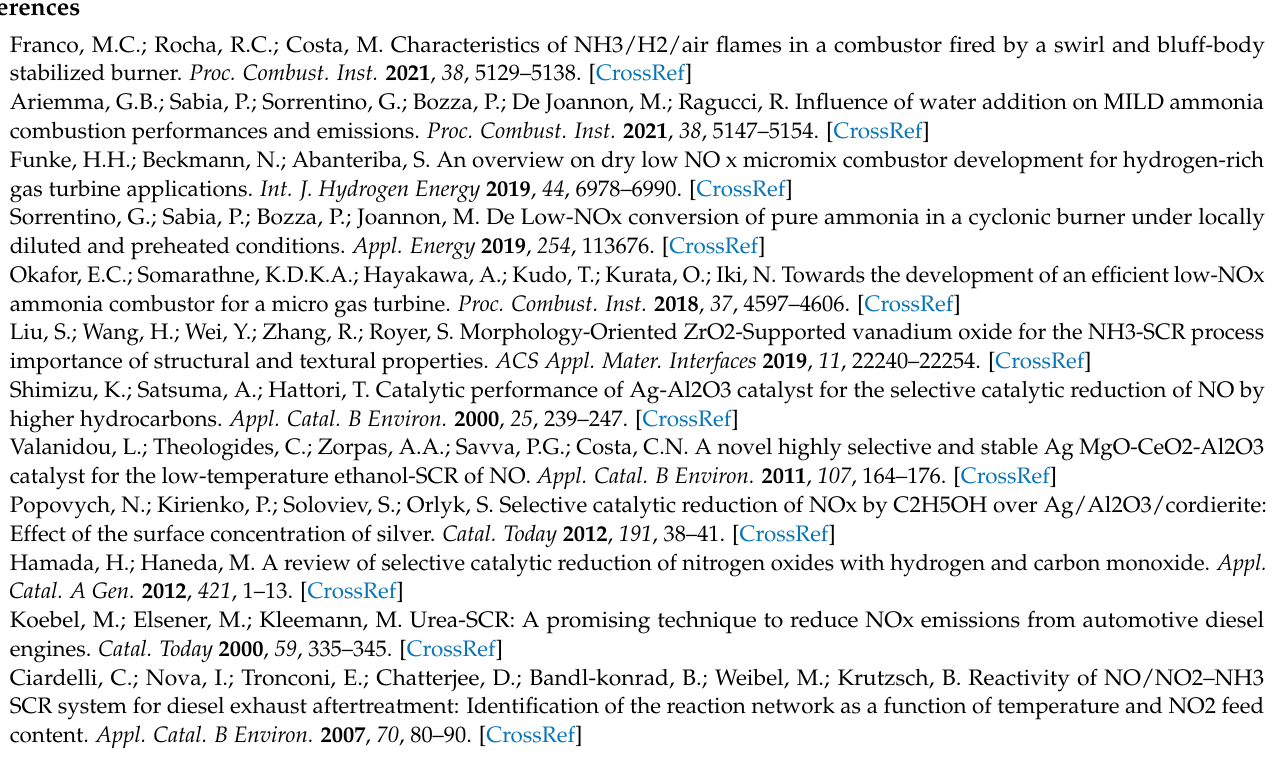
Table S1: Oxygen vacancies values of HPW/CeO 2 (2, 4.5, 9, 16 and 40 wt% W)